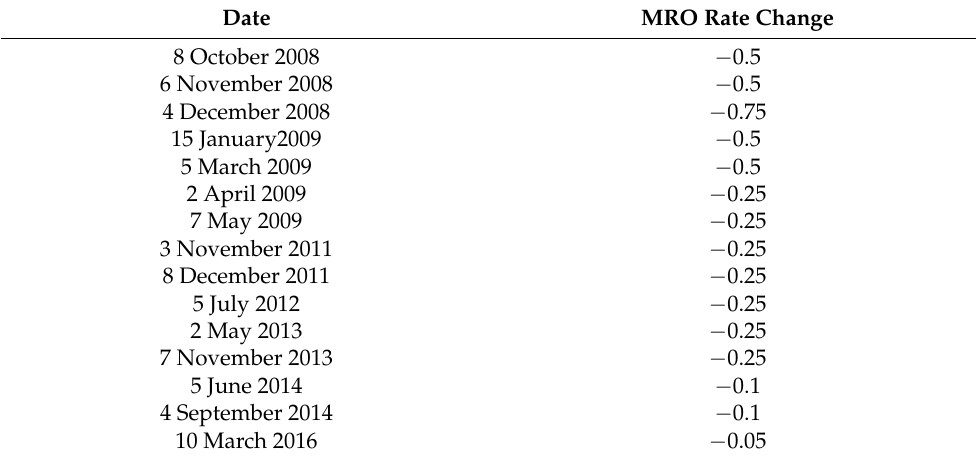
Table A2. MRO rate reduction announcement